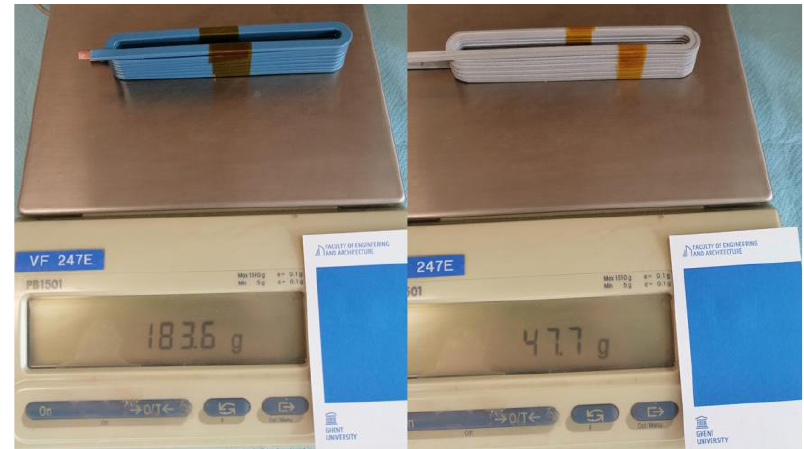
Figure A1. Assembly of a test sample with a cooling jacket for temperature control.